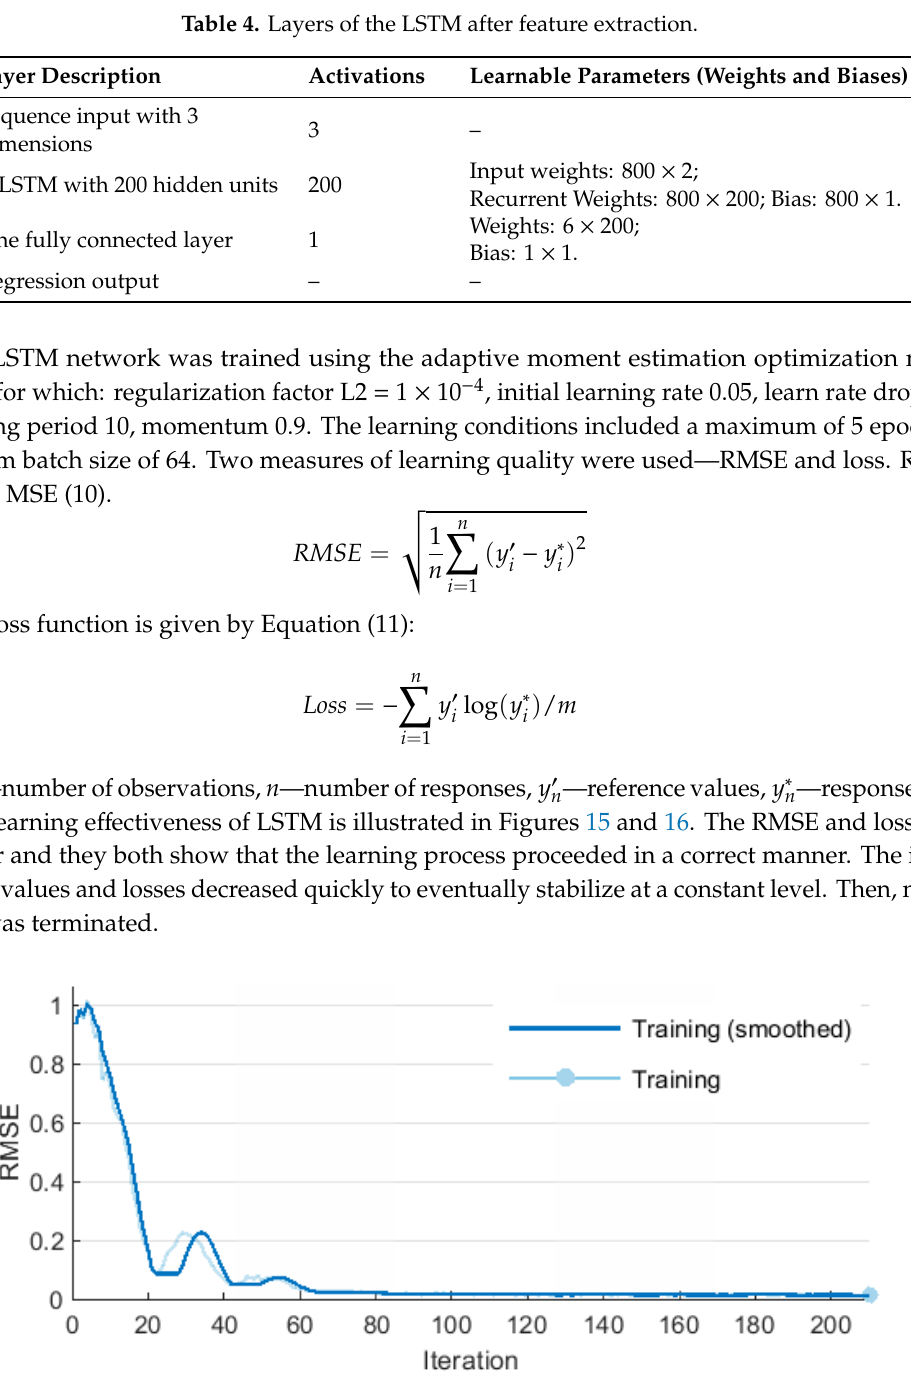
Figure 15. Training performance for LSTM.